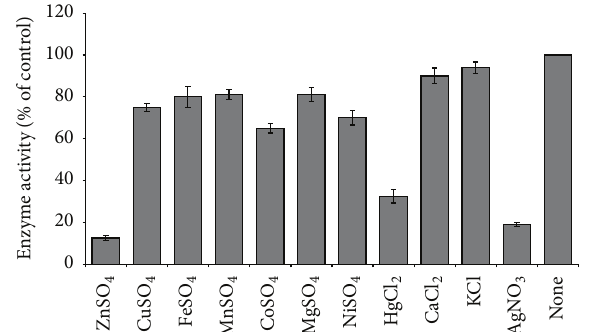
Figure 5: Effect of metal ion on the intracellular sucrase enzyme activity. The purified enzyme was preincubated with metal ions for 10min at room temperature and the activity assay was performed in 50 mM sodium acetate buffer at pH 6.0. The enzyme activity in absence of metal ions was considered to be 100% and compared the relativeactivityoftheenzymeinpresenceofdifferentmetalions.The value presented corresponds to the mean value of three